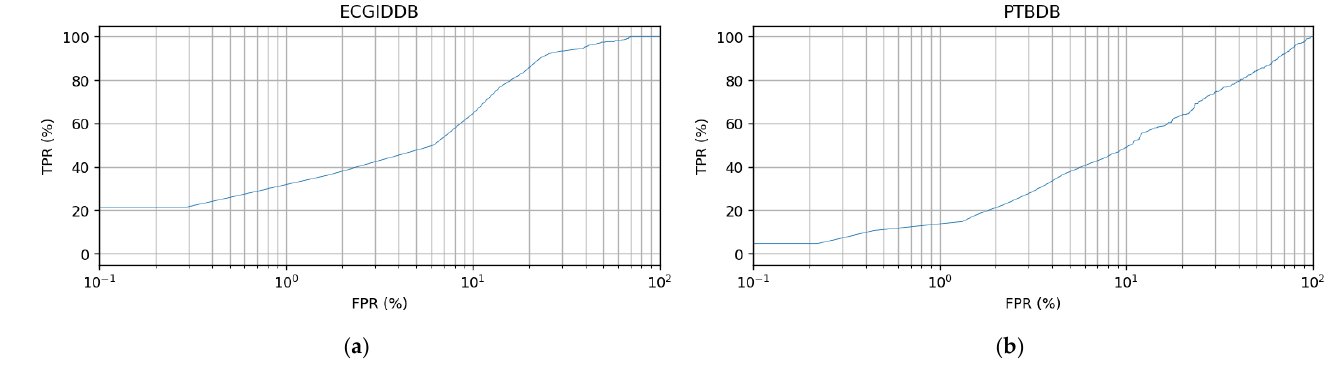
Figure A3. ROC curves are used to evaluate the individual verification performance tested over long time separation for: ( a ) ECGIDDB, ( b ) PTBDB.